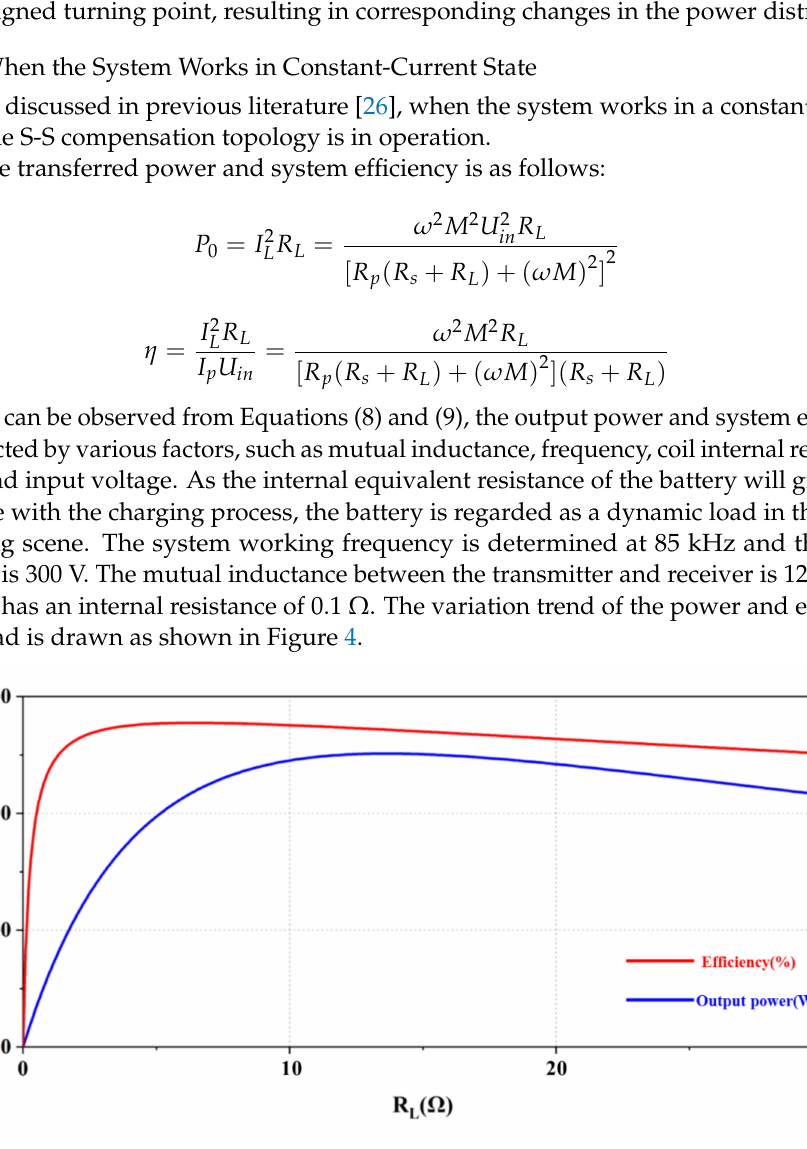
Figure 4. Variation of the output power and efficiency with load resistance for the S-S